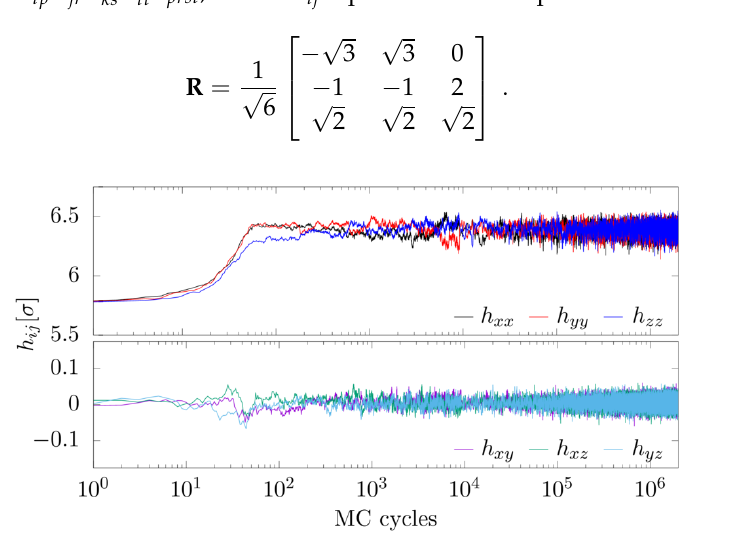
Figure 2. Components of the simulation box of the system versus MC cycles, studied at: N = 256, c = 10.94%, p ∗ = 100, κσ = 10 and β(cid:101) =